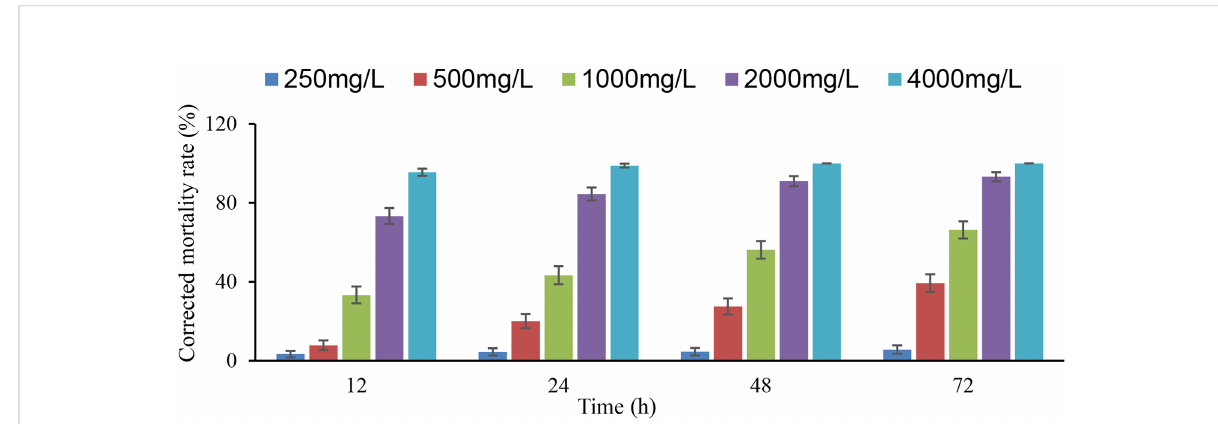
FIGURE 4 Corrected mortality rate of different concentrations of L-nicotine on Diaphorina citri